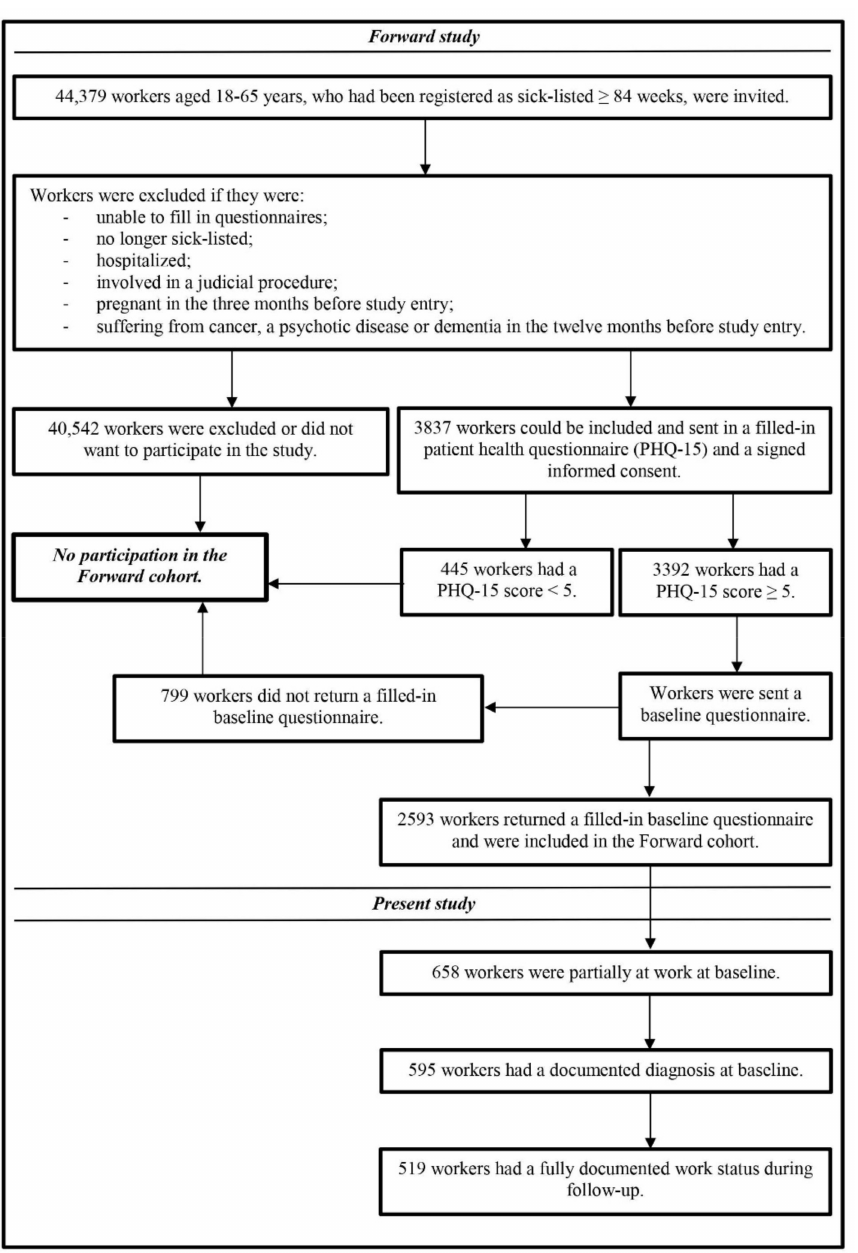
Figure 1. Flow chart of the study design of the Forward cohort and the study population of the present